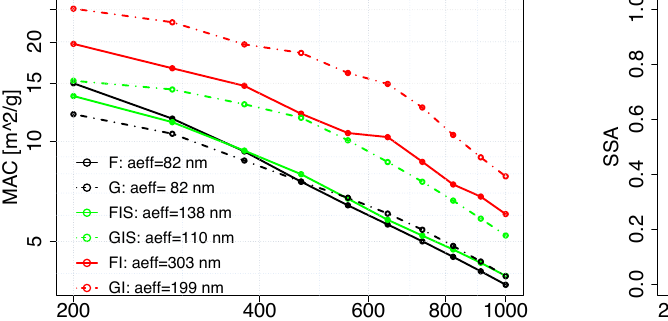
) is 1.8 g/cm 3 . All BC m kd < 0.3. | |